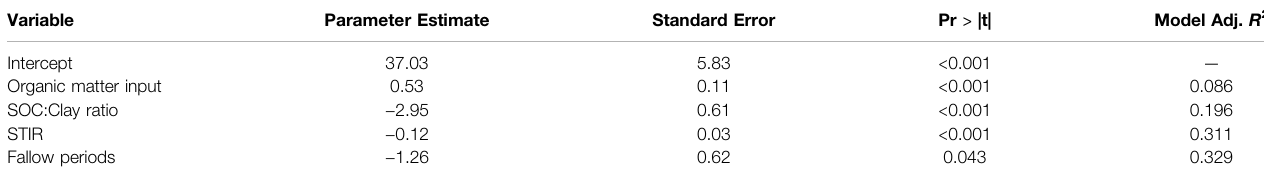
TABLE 5 | General linear model of SOC annual change rates as a function of farming practices and soil properties.